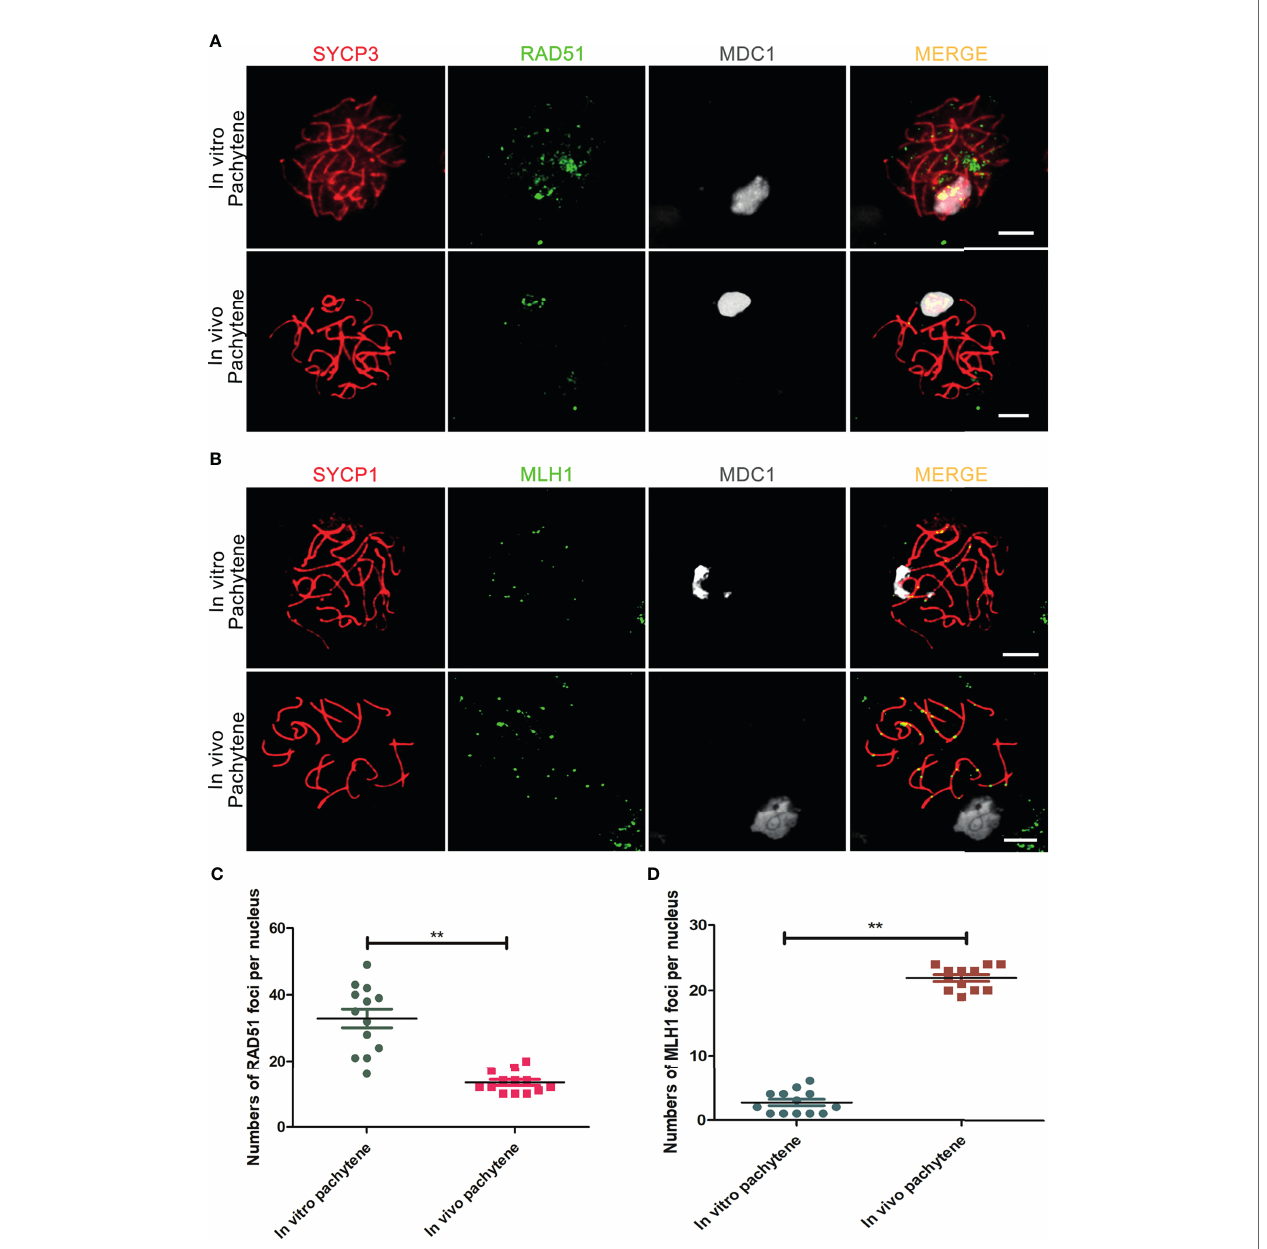
FIGURE 3 | Incomplete meiotic recombination and inef fi cient meiotic crossover formation in vitro . (A) DSBs-repair sites, marked with RAD51, are not completely resolved in in vitro - generated pachytene spermatocytes stained for SYCP3 (red), RAD51 (green) and MDC1 (white). In vivo pachytene spermatocytes are used for a positive control. (B) Meiotic crossovers marked with MLH1 in in vitro - generated pachytene spermatocytes stained for SYCP1(red), MLH1 (green) and MDC1 (white). In vivo pachytene spermatocytes are used for a positive control. Scale bars, 5µm. (C, D) Quanti fi cation of RAD51-foci per cell nucleus of in vitro pachytene spermatocytes (n=13) and in vivo pachytene spermatocytes (n=13) and (D) Quanti fi cation of MLH1-foci per cell nucleus of in vitro pachytene spermatocytes (n=13) and in vivo pachytene spermatocytes (n=12). Data are presented as the mean ± SEM. **p < 0.01 (Student ’ s